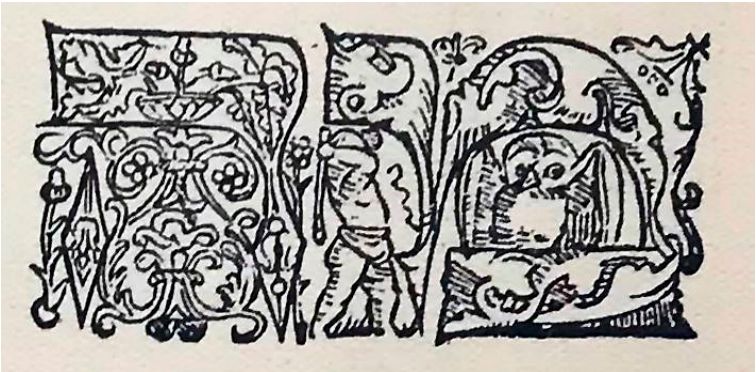
Figure 2. Decorated initial word, woodcut. Passover Haggadah, Prague, Gershom Cohen, 1527. Photograph: Zvi Orgad, 2019.